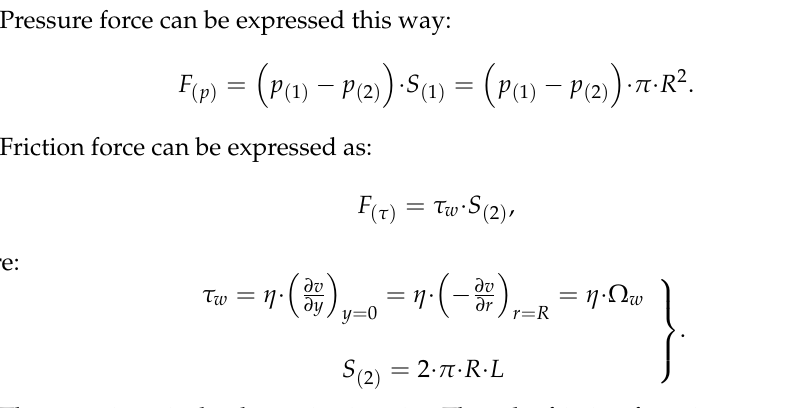
Figure 5. Pressure and friction forces in the pipe.